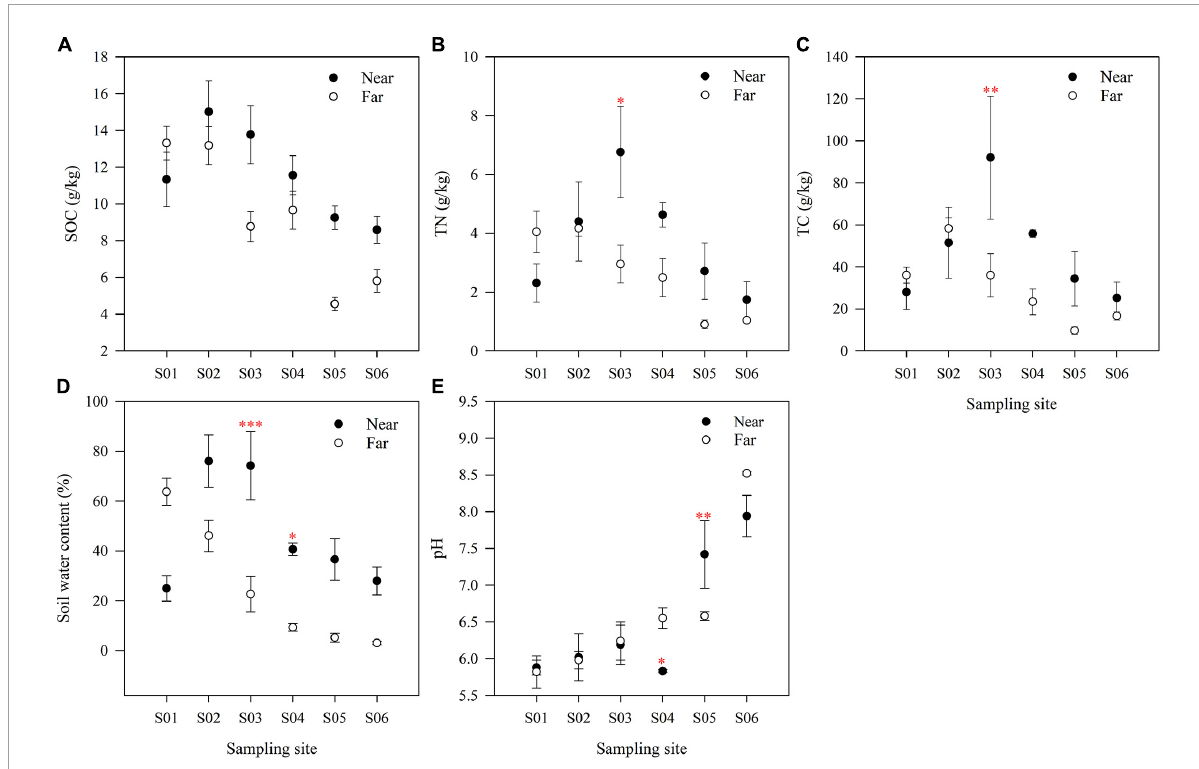
FIGURE2 The soil organic C (A) , soil total N (B) , soil total C (C) , soil water content (D) and soil pH (E) at each sampling site in the riparian zone. The data are means ± SE ( n = 3). Significant differences between the near-bank and the far-bank samples at the same sampling site were determined based on the Kruskal-Wallis Test (* P < 0. 05; ** P < 0.01; *** P < 0.001).